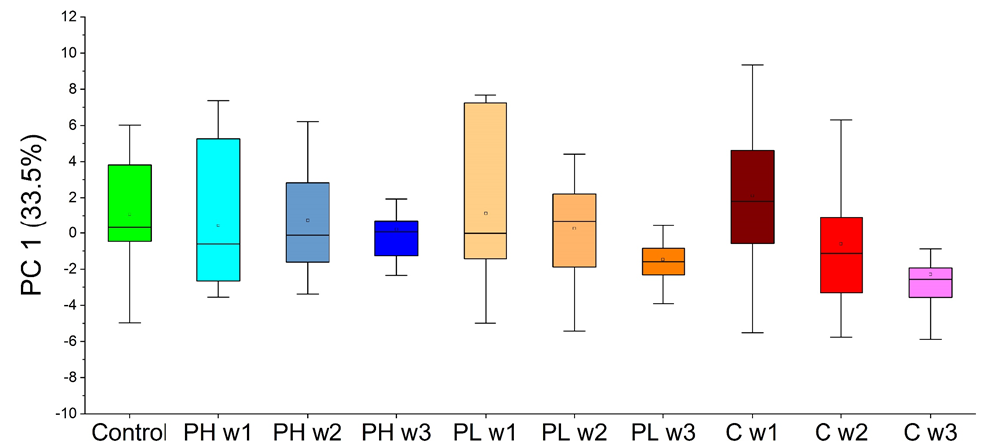
Figure 5. PC 1 scores in one dimension using the VOCs highlighted through approach 2 for all sample classes of interest (PH = pitavastatin high, PL = pitavastatin low, C = cancer). No significant trends are observed in the data.